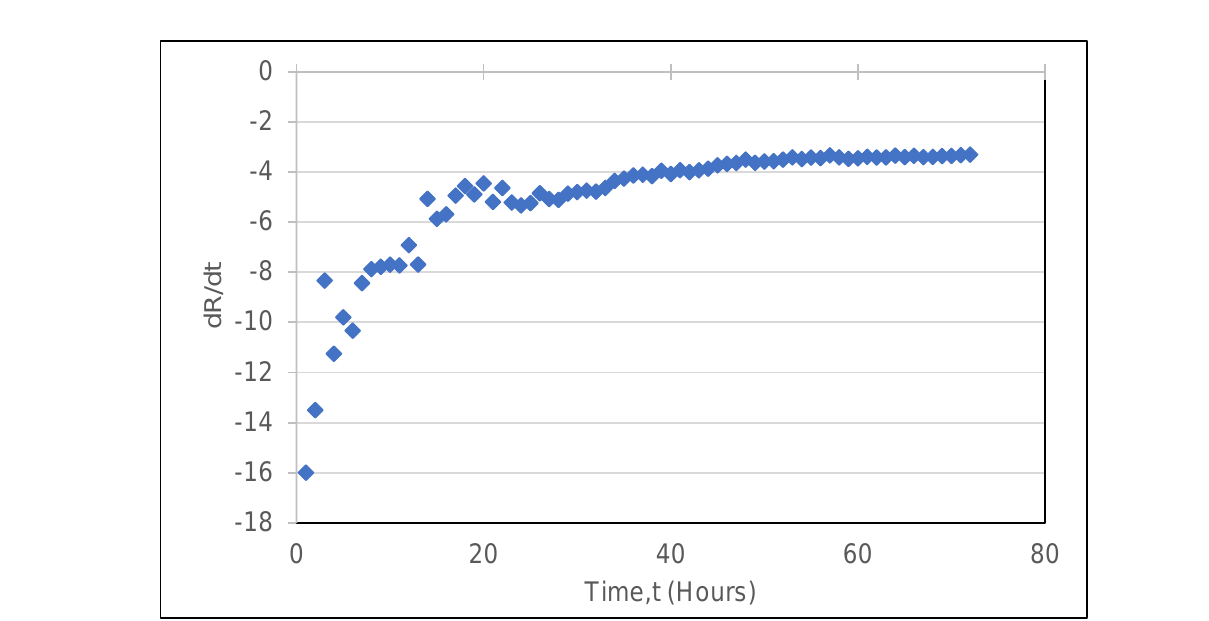
Figure 16. ( a ) The relative humidity (%RH) values, and ( b ) temperature (°C) recorded throughout the procedure.